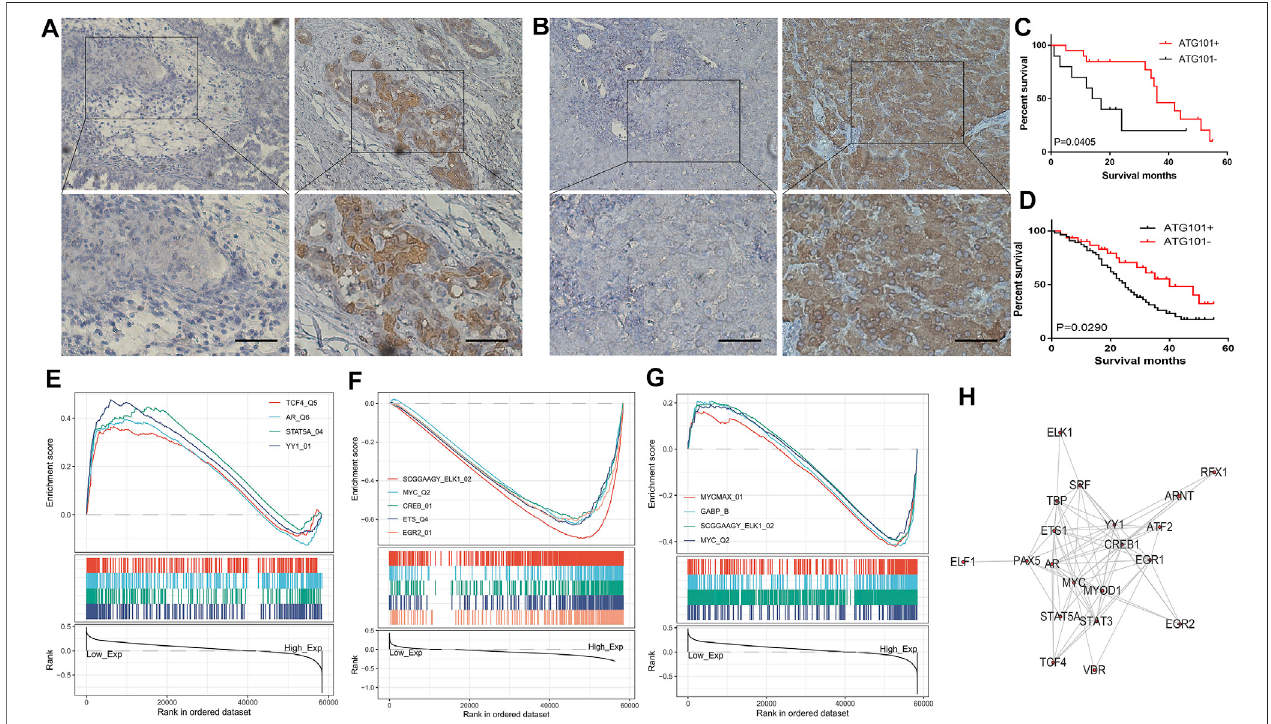
FIGURE7| ImmunohistochemicalstainingofCHOLandLIHC.Thesampleswereobtainedfrompatientsaftersurgeryinhospitals. (A,B) Thesurvivalanalysiscurve of CHOL and LIHC. (C,D) The pathways are negatively and positively correlated with ATG101 expression in LIHC. The transcription factors are positively and negatively correlated with ATG101 expression in CHOL (E,F) . The transcription factors are correlated with ATG101 expression in LIHC (G) . Twenty-one common genes related to ATG101, CHOL and LIHC (H) .